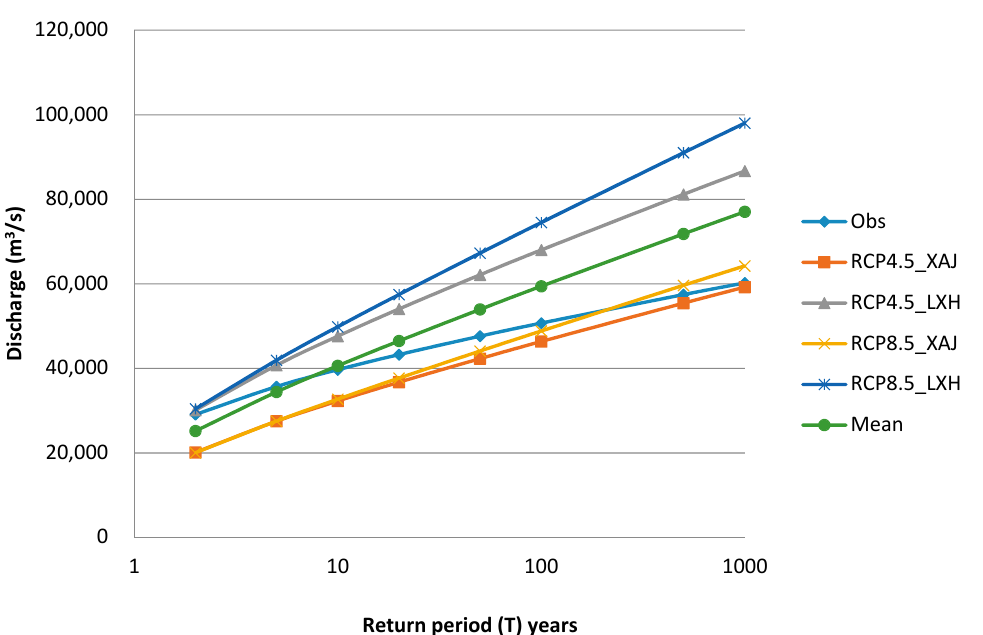
Figure 13. Comparisons of flood magnitude under two climate change scenarios in two hydrological models based on the return period.